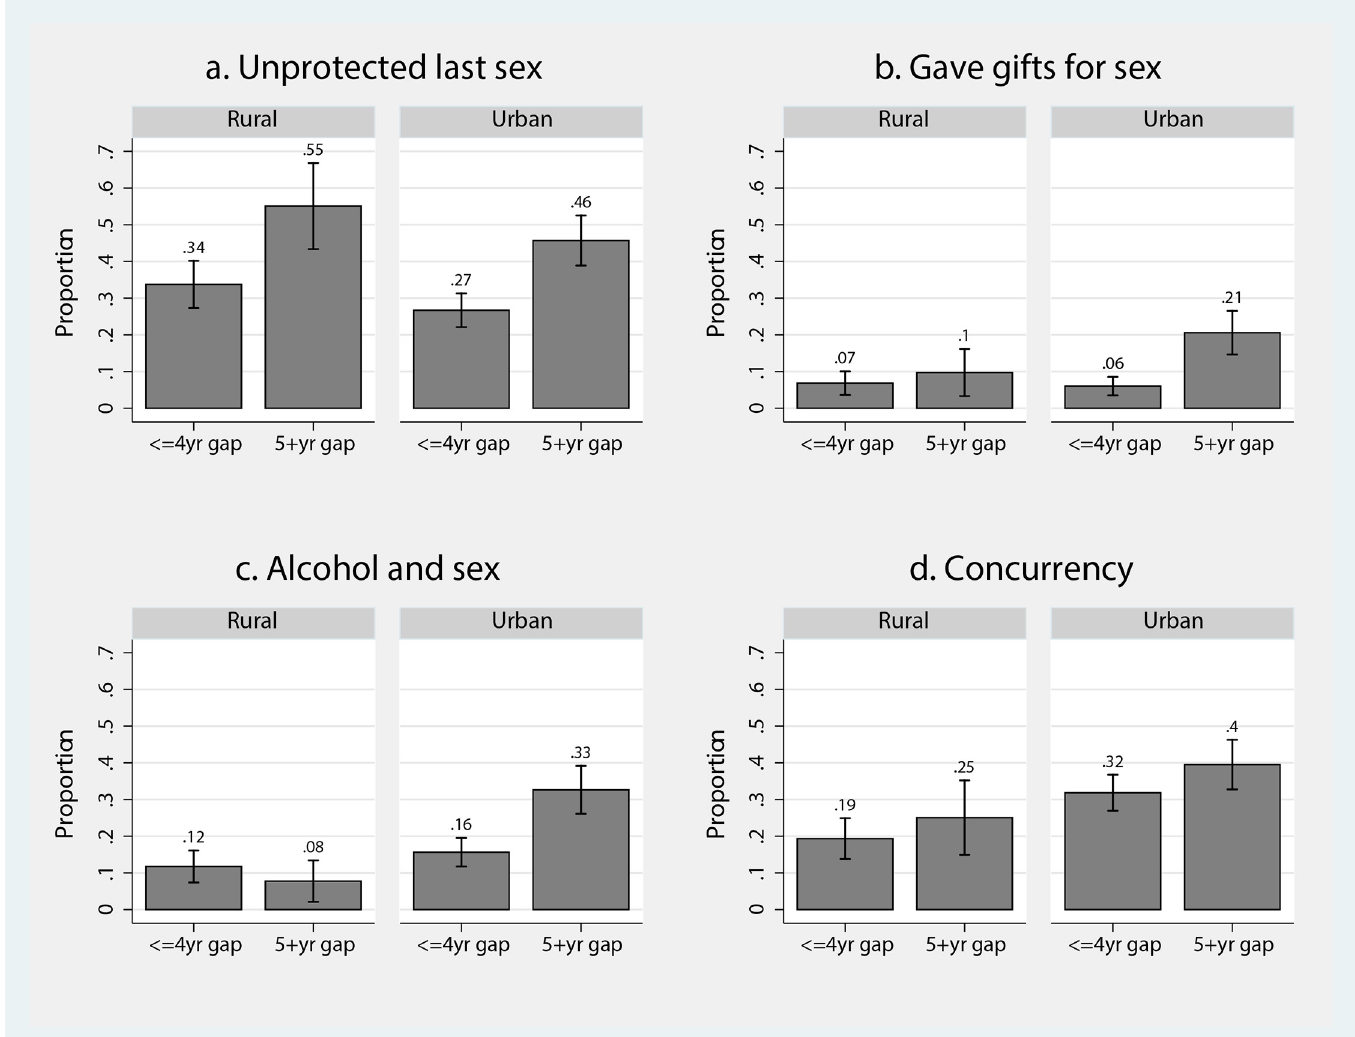
Fig 2. Sexual behaviours reported by men in partnerships with 16 – 24 year old women by partnership type (age-disparate v age-similar) and geographic (urban/rural) setting. 2a: unprotected last sex; 2b: gave gifts for sex; 2c: alcohol and sex; 2d: